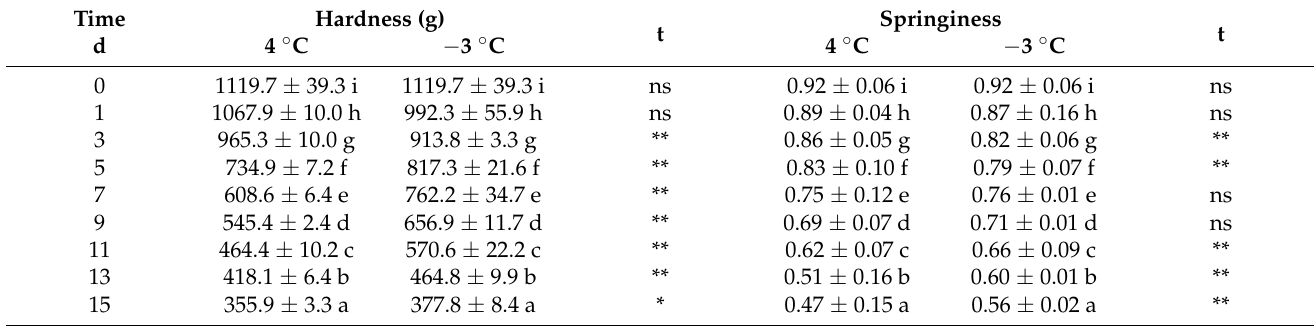
Table 1. Changes in the texture of Coregonus peled fillets stored at 4 ◦ C and − 3 ◦ C for up to 15